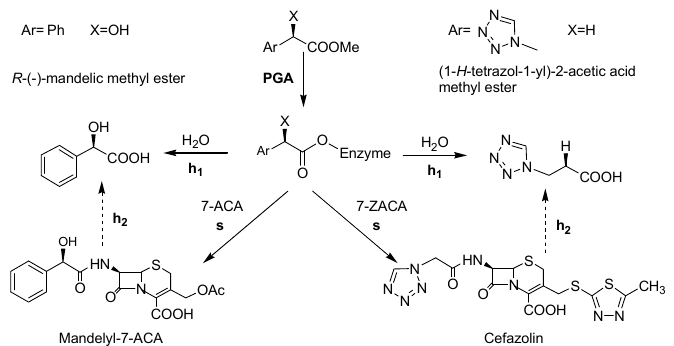
Scheme 1. Kinetically controlled acylation of β -lactam nuclei (7-ACA and 7-ZACA, respectively) catalyzed by PGA discussed throughout the